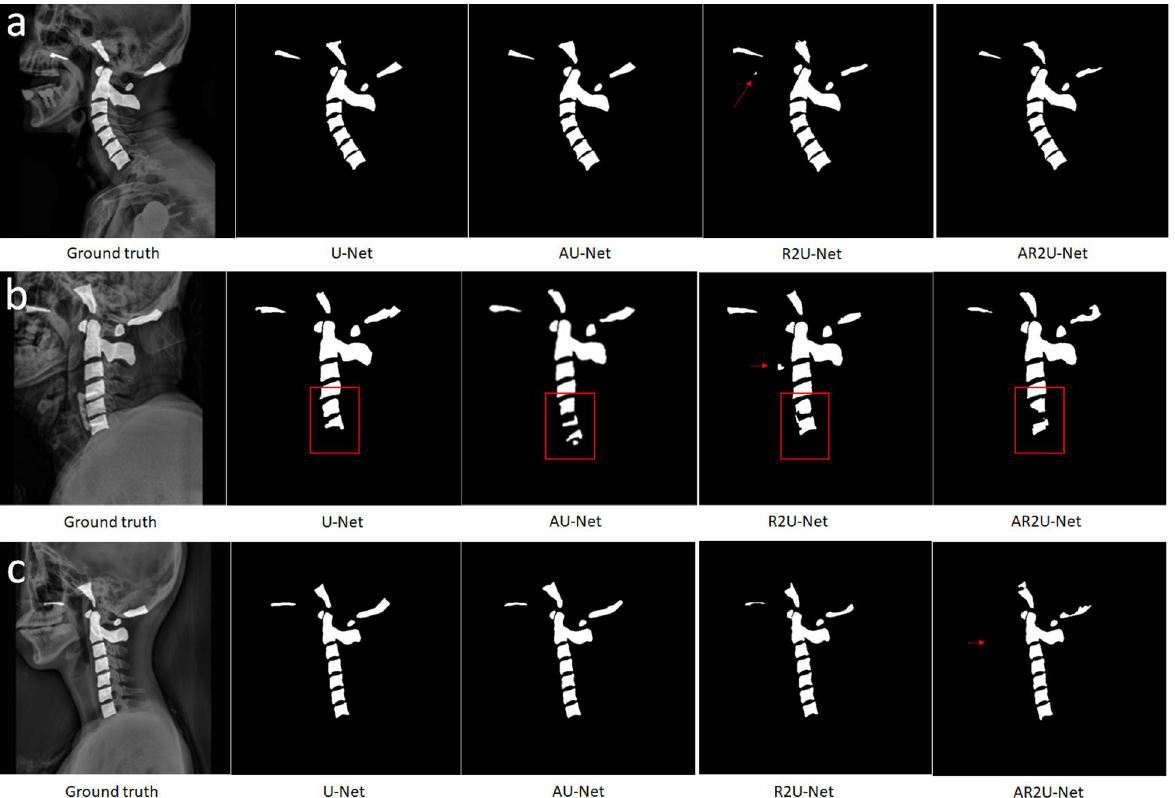
Figure 4. Example of errors found in U-Net predicted segmentation masks. Red arrows and red boxes refer to errors found in segmentations with certain U-Net models. ( a ) Example of a false positive in R2U-Net predicted segmentation masks. ( b ) Example of fragmented segmentations affected by spinal implants and false positives in R2U-Net predicted segmentation masks. ( c ) Example of omitted segmentation in AR2U-Net predicted segmentation